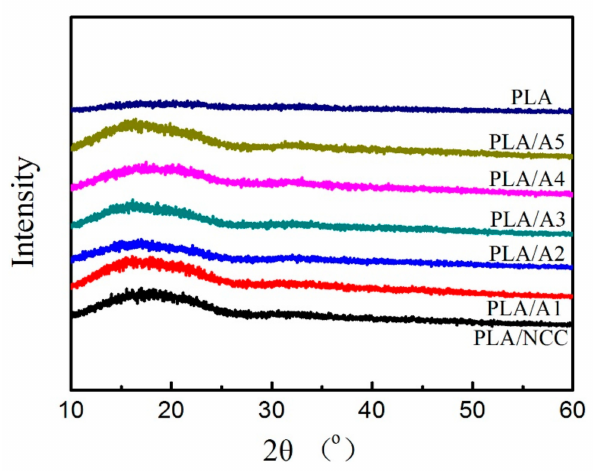
Figure 6. XRD characteristics PLA, PLA / NCC and PLA / NCC-HAP with di ff erent ratios of NCC to HAP.